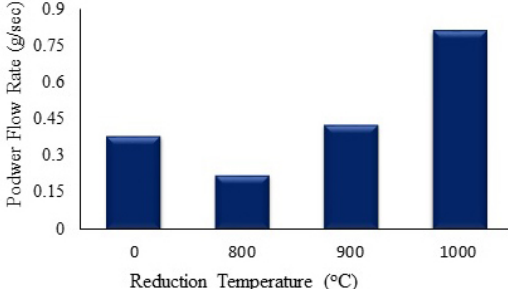
Figure 12. Flow rate (gram/sec) of iron powder produced at different reduction